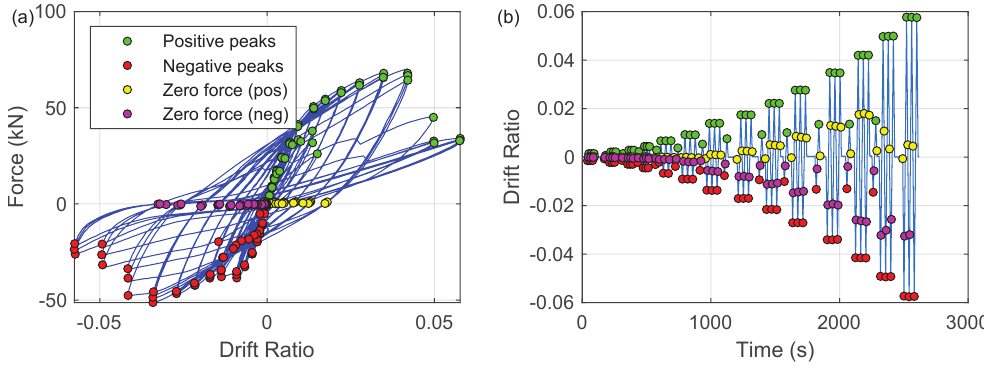
Figure 25. ( a ) Force–drift ratio relationship. ( b ) Drift ratio